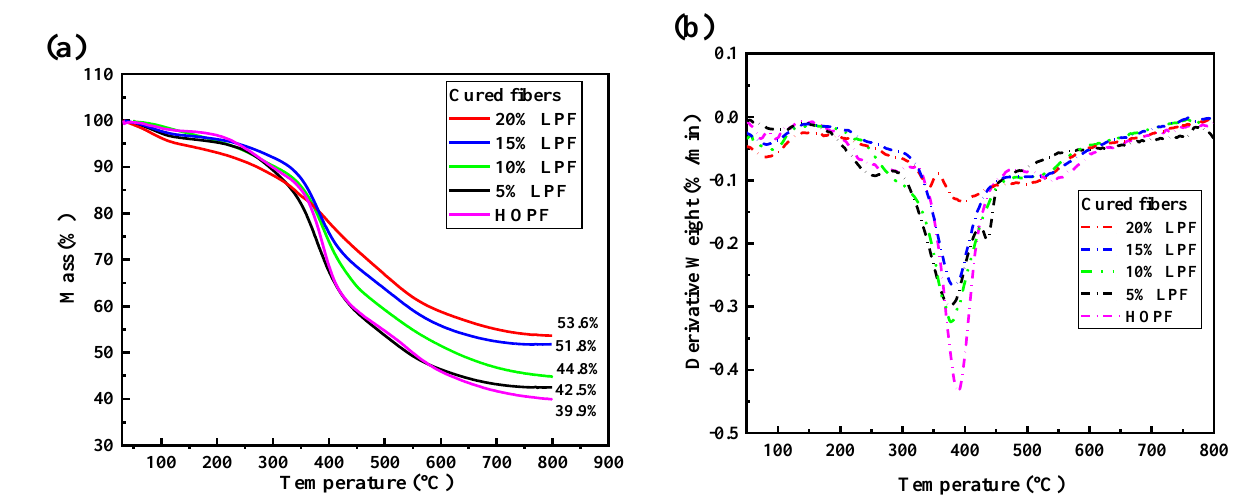
Figure 5. ( a ) TG curves of cured LPFs and HOPF; ( b ) DTG curves of cured LPFs and HOPF.